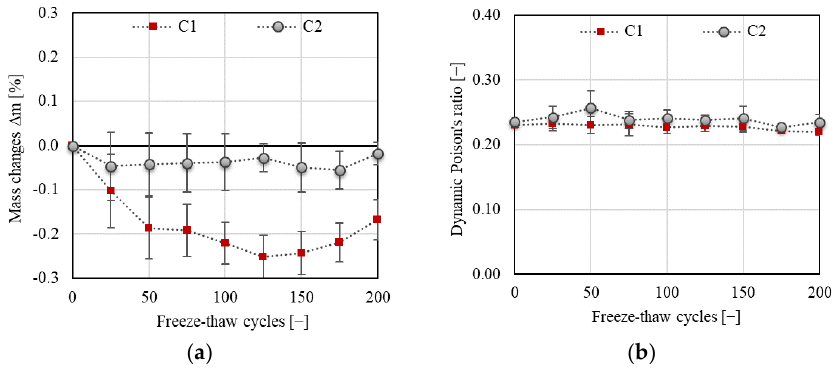
Figure 6. ( a ) Changes in mass; ( b ) Poisson’s ratio.